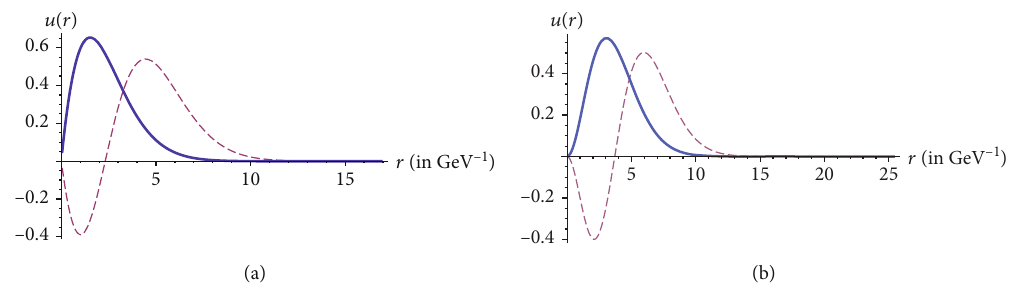
3 P 1 states (a) and J states (b). Solid curve represents the